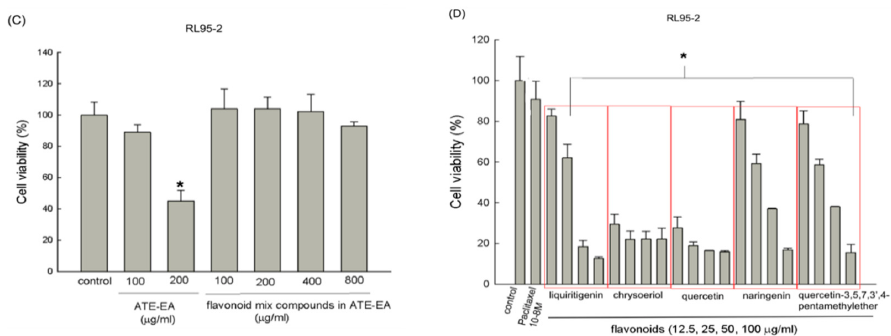
Figure 3. Effects of flavonoid compounds from ATE-EA on the viability of HEC-1A and RL95-2 cells. HEC-1A cells were treated with serial concentrations of flavonoid compounds ( A ) and the constituents ( B ) of ATE-EA for 48 h. RL95-2 cells were treated with serial concentrations of flavonoid compounds ( C ) and the constituents ( D ) of ATE-EA for 48 h. Data are expressed as means ± SD ( n = 3). * p < 0.05, compared with the control group at the basal level. ATE-EA, ethyl acetate fraction of the adlay testa ethanolic extract.